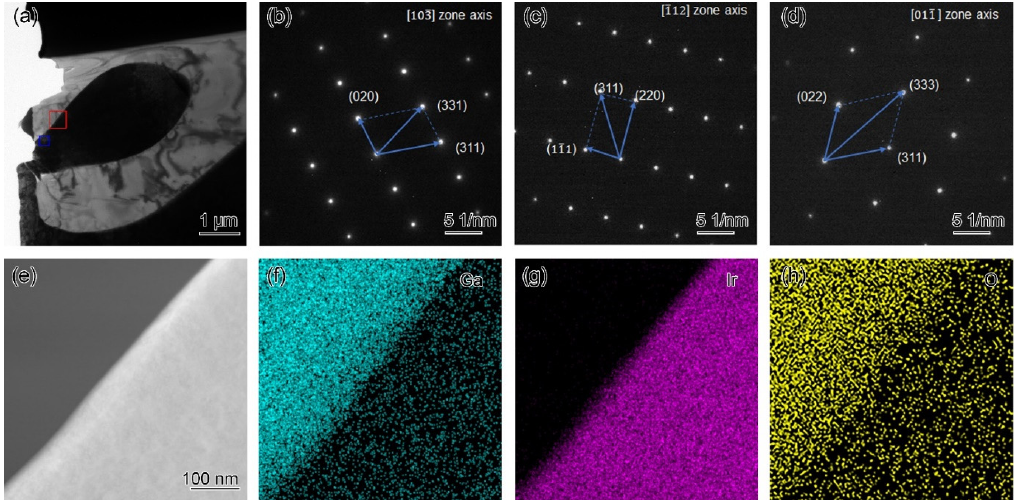
Figure 3. Compositional and structural characterizations of the floating particles. ( a ) Low-magnification cross-sectional TEM image, showing the difference in the contrast of two phases. ( b – d ) SAED patterns of the region marked by a blue square in ( a ). These diffraction patterns correspond to the [103(cid:3364)] , [1(cid:3364)12] , [011(cid:3364)] zone axes of Ir, respectively. ( e ) HAADF-STEM image of the area marked by a red square in ( a ), showing the sharp β -Ga 2 O 3 /Ir interface. ( f – h ) The corresponding EDX mapping images. The purple, blue and yellow colors correspond to Ir, Ga and O elements, respectively. After cooling, the floating particles were embedded into the matrix of β -Ga 2 O 3 to form the β -Ga 2 O 3 /Ir interface, which was first studied using the aberration-corrected HAADF- STEM technique (Figure 4). In Figure 4a, the sharp and straight interface can clearly be observed. Due to the different crystal structures of β -Ga 2 O 3 and Ir, only lattice fringes as- sociated with Ir appeared along the [211] zone axis of fcc -structured Ir. Careful observation of the atomic-scale image (Figure 4b) indicates that the β -Ga 2 O 3 /Ir interface had small con- tinuous fluctuations at the nanoscale, but it could still maintain the overall flatness in a wider range. The atomic driving force of such interface relaxation will be discussed later.